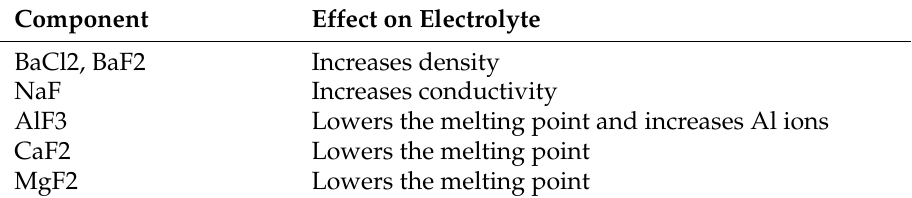
Table 4. The role of each component of the electrolyte, data from